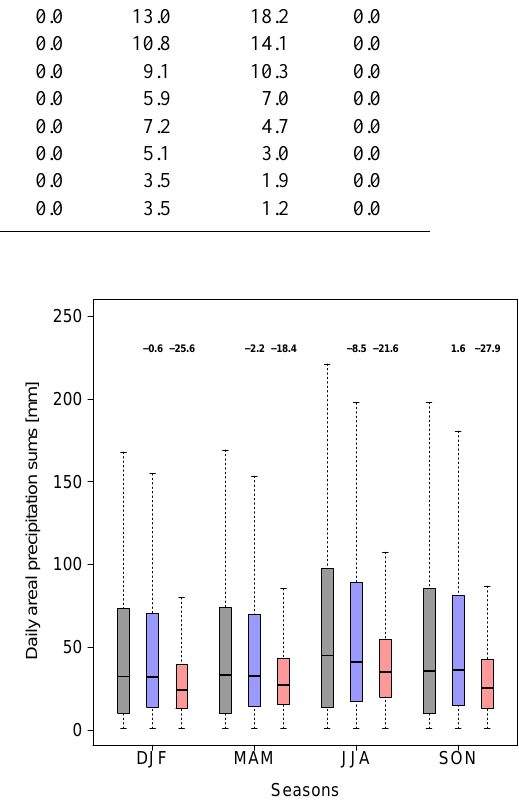
Figure 7. Daily non-zero precipitation sums over the catchment for the four seasons during 1961–2011. Daily precipitation intensity of the eight stations is summed and days with an area sum of zero are excluded. Box plots of observed daily sums (grey), of multi-site simulated time series (blue) and of single-site simulated time series (red) are shown. The WG models were run 100 times over a 51-year time period. The numbers (in percentage) indicated above the cor- responding model represent the relative deviation of the simulated median from the observed